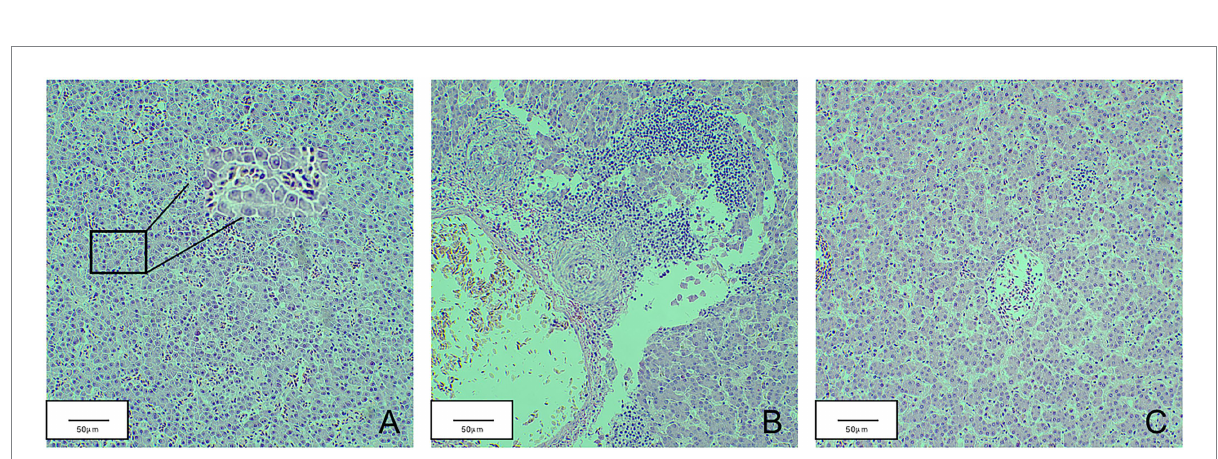
FIGURE 8 Pathological sections of chicken liver in the JS2020-PFV group. (A) Part of the liver spinal cord around the central area of liver disorder. (B) Eosinophil infiltration. (C) The hepatic sinusoidal space is dilated and